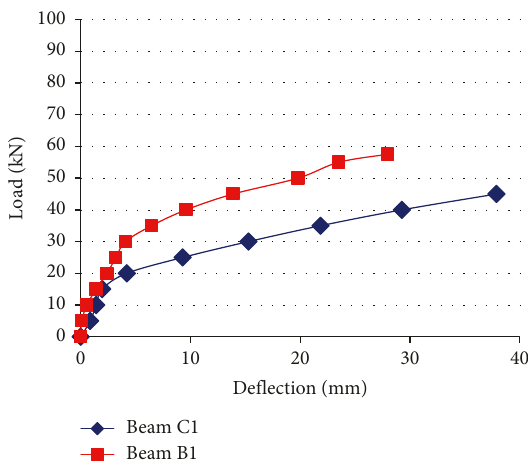
Figure 10: Effect of clear span length of the beam on load deflection response without carbon fiber strengthening.